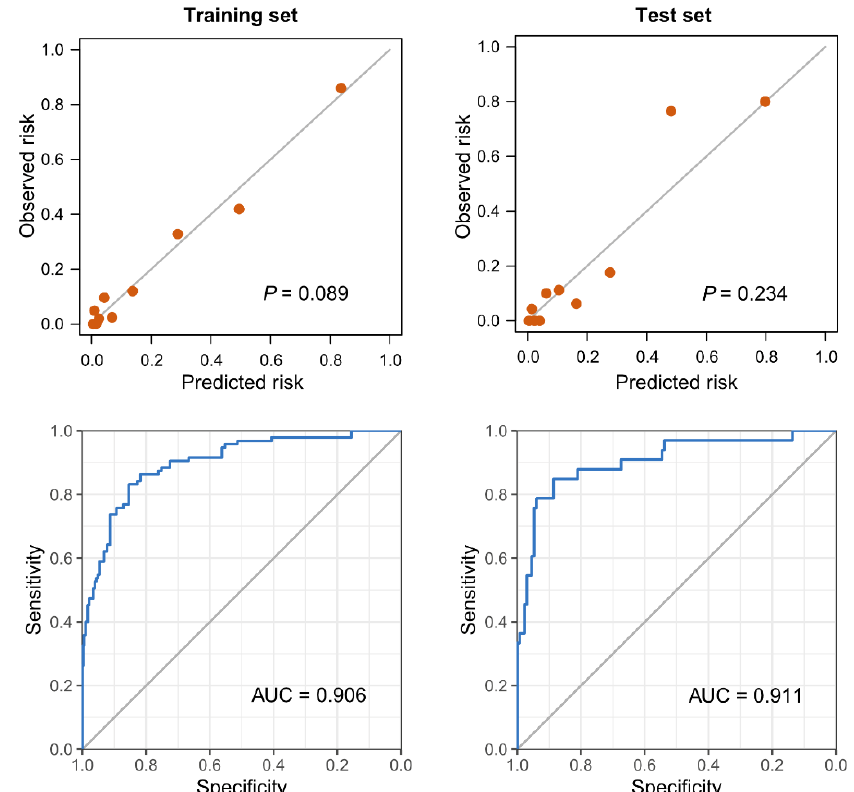
Figure 3. Calibration plots and receiver operating characteristics curves for the scoring model, predicting the requirement of mechanical ventilation. The p -values in the calibration plots were calculated by the Hosmer-Lemeshow test to assess the goodness of fit.